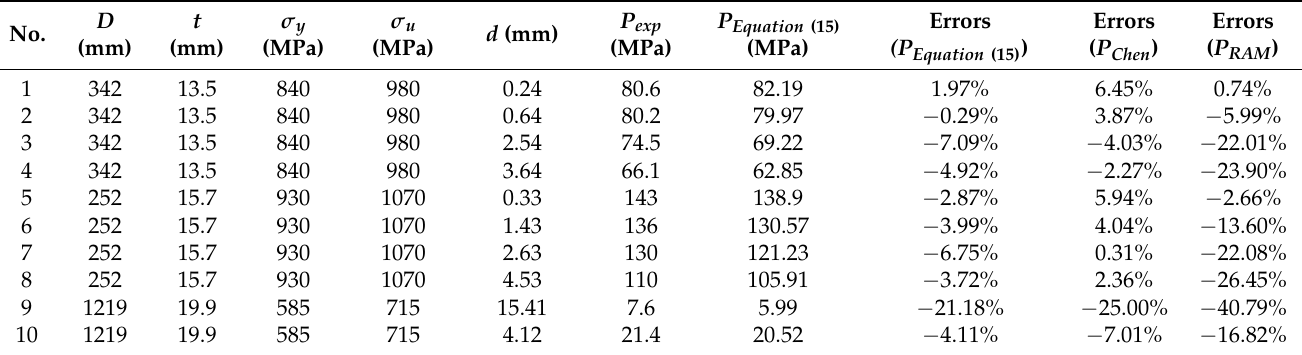
Table A1. Errors of predictions compared with the actual burst pressure and two other evaluation model. (Experimental data source